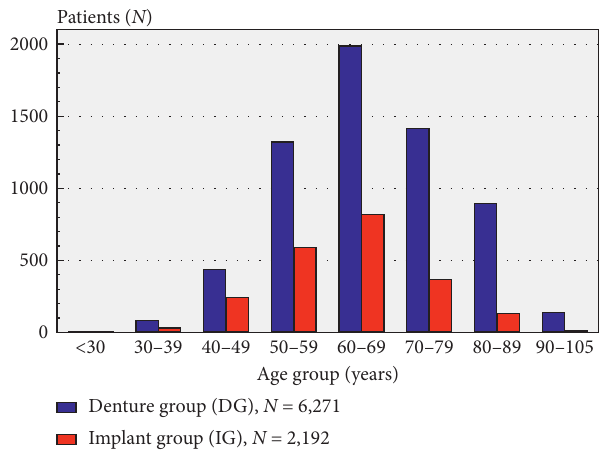
Figure 3: Distribution of 8463 edentulous patients with regard to age in both study groups (denture group, DG/implant group, IG).